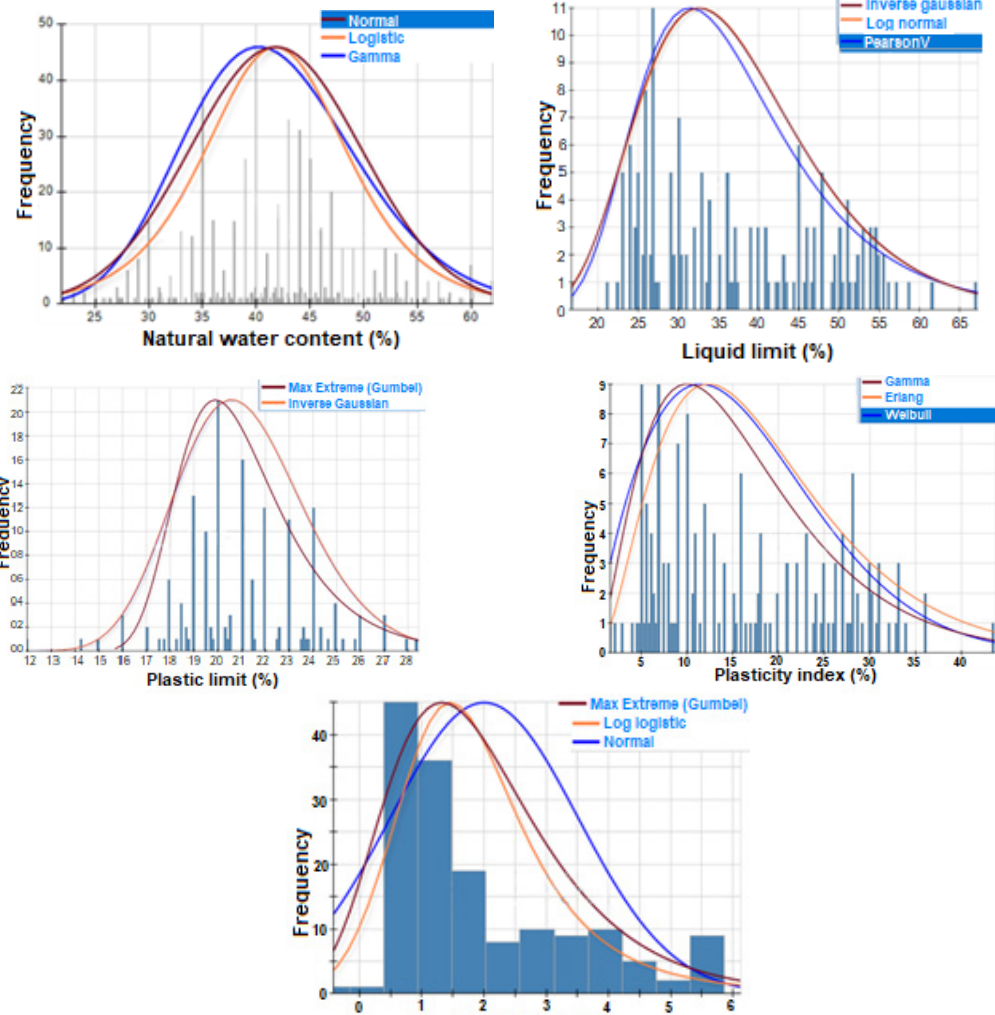
Figure 7. The statistical distributions of natural water content and the Atterberg